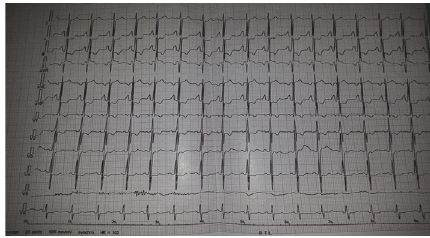
Figure 2: Electrocardiogram showing right ventricular hypertrophy and a right auricular